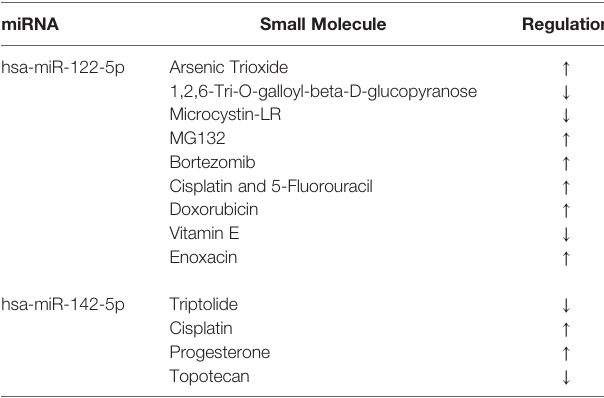
TABLE 2 | The prediction of interaction of small molecules with miR-122-5p and